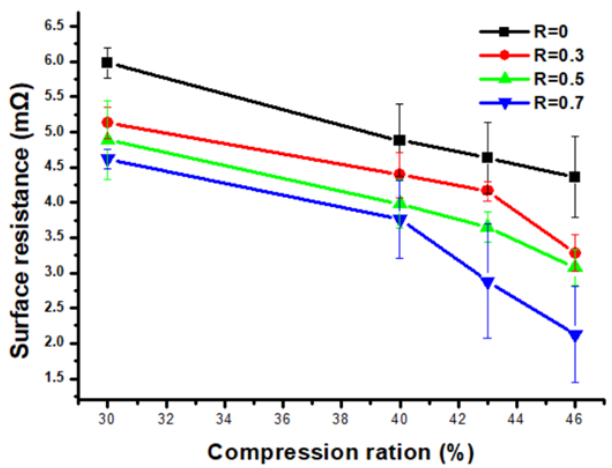
Figure 7. Effects of fillet radius and compressibility on resistance.